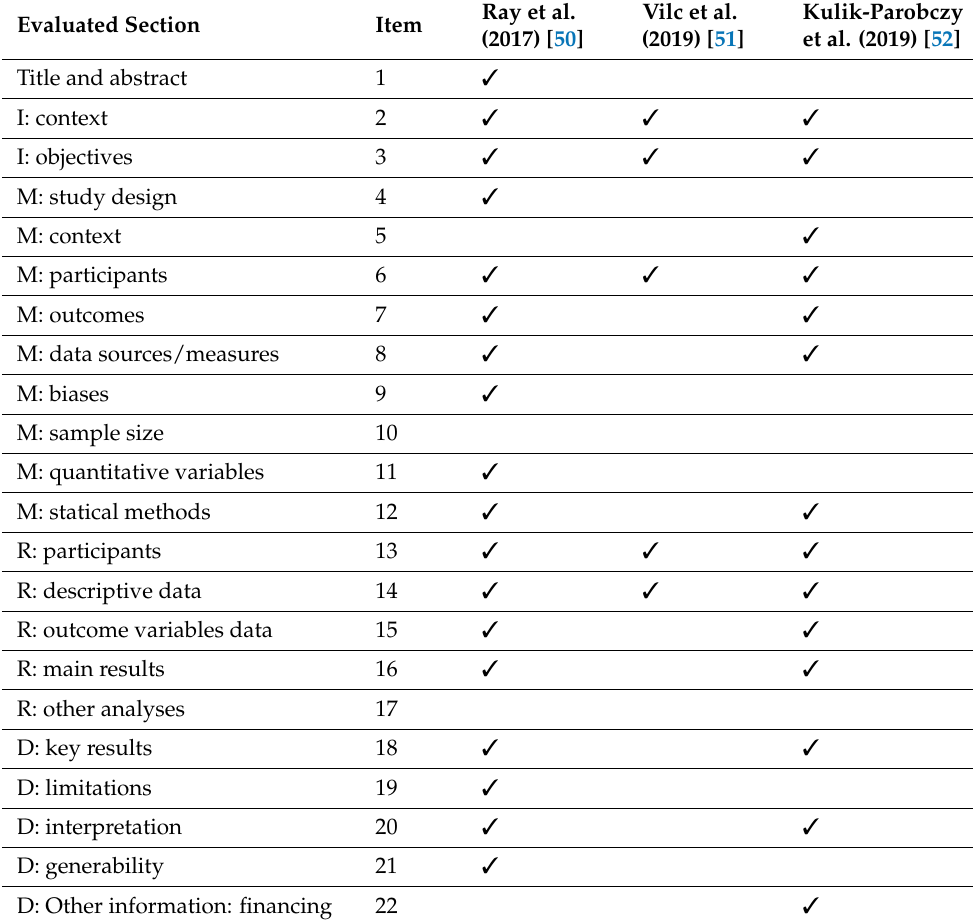
Table 3. Quality assessment of observational studies using the STROBE Statement [51].